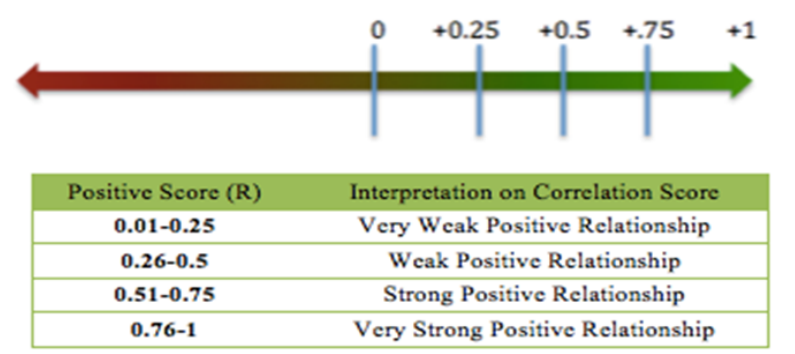
Figure 2: Interpretation on correlation scores